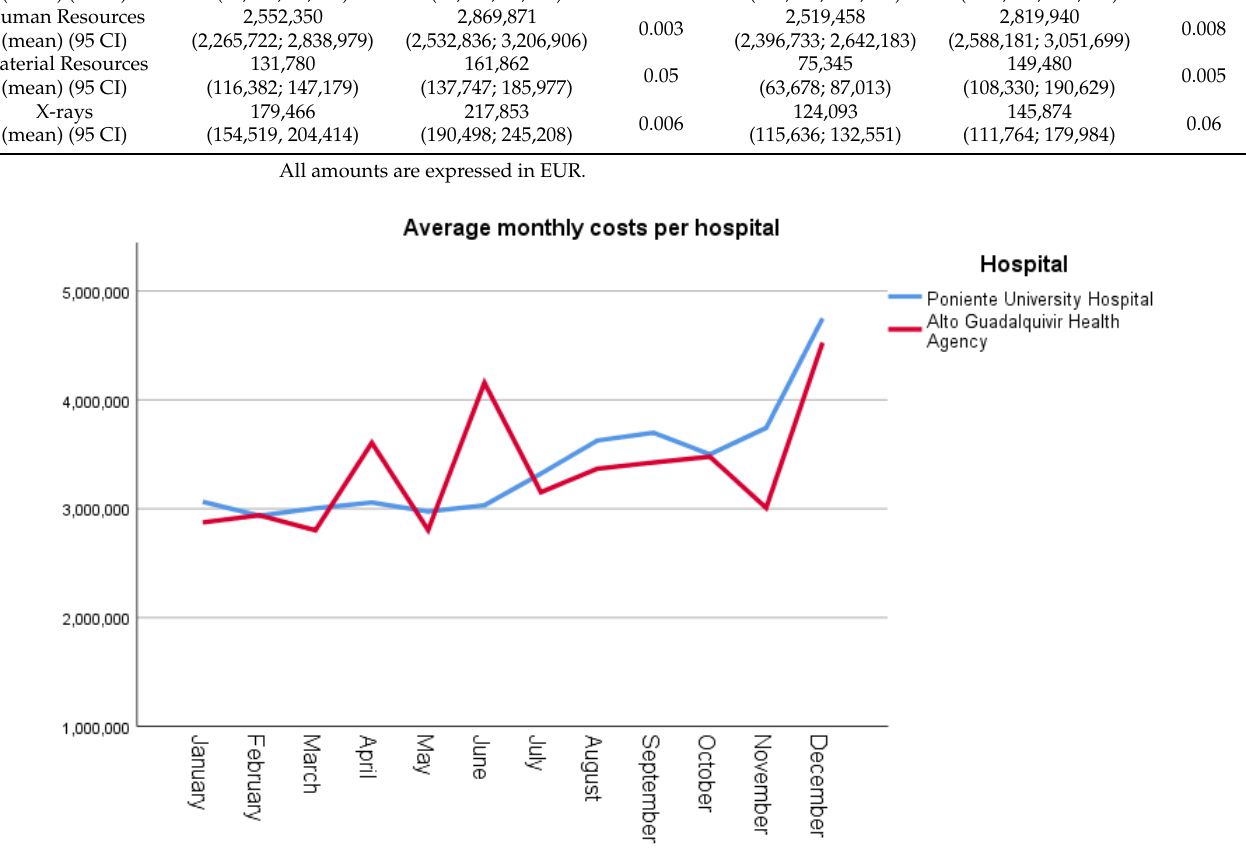
Figure 3. Average monthly costs incurred in both regional hospitals.